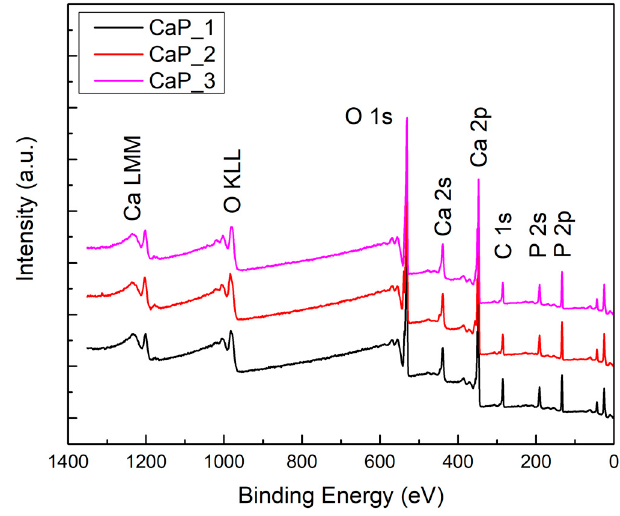
Figure 3. XPS survey spectra of CaP coatings.